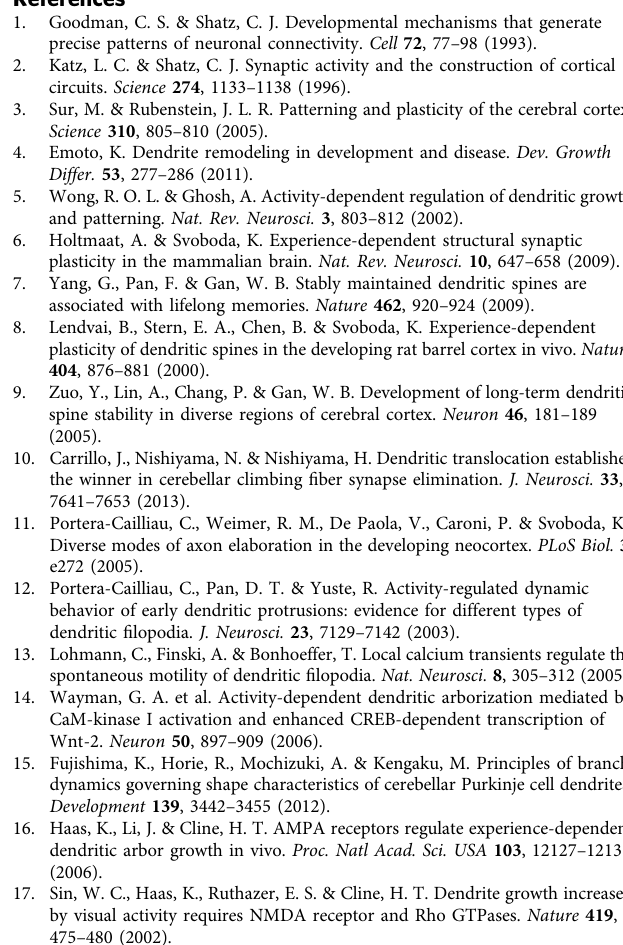
Table 1. Figure 2b: Group 1 (SS) ( n = 35, 39, 38, and 33 neurons from 7, 8, 8, and 6 mice for P3, P4, P5, P6, respectively); Group 2 (SP) ( n = 12, 12, 12, and 8 neurons from 5, 5, 5, and 3 mice for P3, P4, P5, P6, respectively). Figure 2e: Group 1 (SS) ( n = 30, 38, 36, and 29 from 7, 8, 8, and 6 mice for P3, P4, P5, P6, respectively); Group 2 (SP) ( n = 11, 12, 11, and 7 neurons from 5, 5, 5, and 3 mice for P3, P4, P5, P6, respectively). Figure 3d and Supplementary Fig. 3b: n = 28, 12, 36, and 18 BDs for P3 L inside, P3 L outside, P6 L inside, and P6 L outside, respectively. Data were collected from eight eSS neurons of four mice.